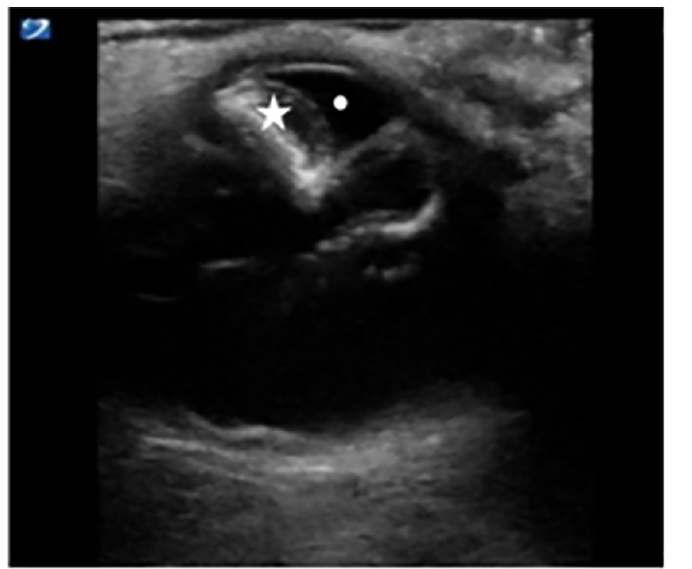
Image 2. Right eye sagittal view depicting echogenic lens indicative of cataract (star), as well as subluxation of lens into anterior chamber (white dot) indicative of anterior dislocation of lens.